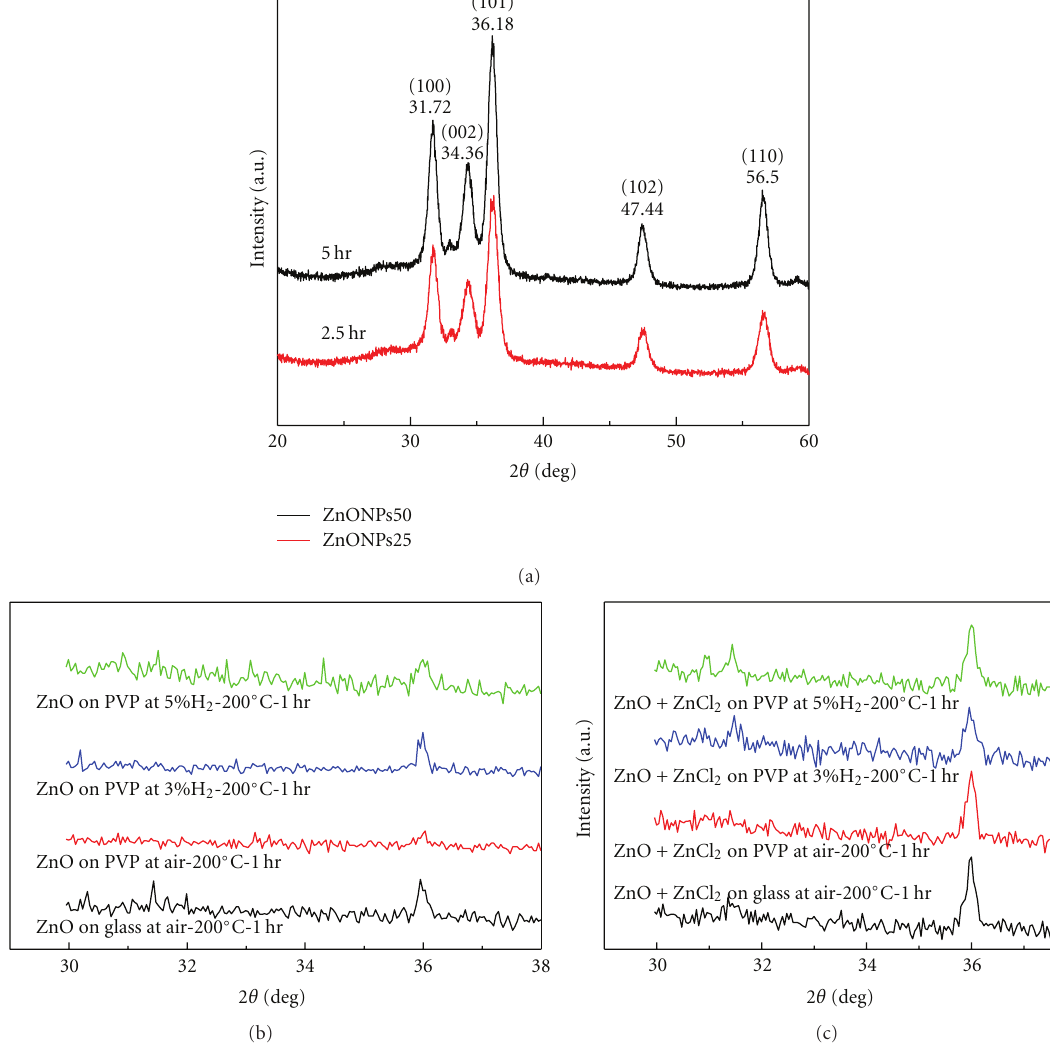
Figure 6: XRD patterns of ZnO with di ff erent composite of inks after annealing in various atmospheres: (a) nanoparticles of di ff erent synthesis times; (b) and (c) spin-cast films with inks of ZnO-NPs and ZnO-NPs/Zn 2+ ,